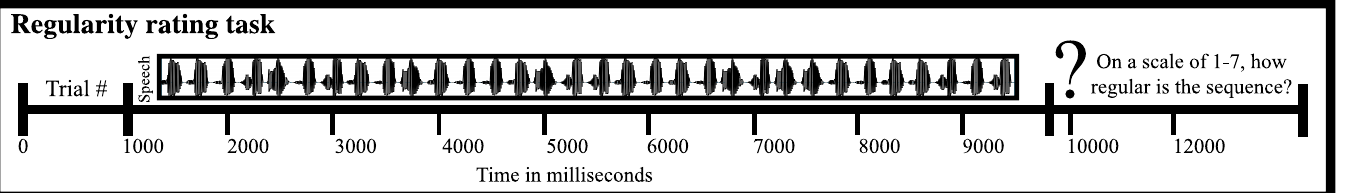
Fig 1. Experimental design. The trial number was displayed for 1000 ms and was followed by the an auditory sequence which lasted for 8800 ms. A question mark then appeared triggering participants to determine sequence regularity on a scale of 1 to